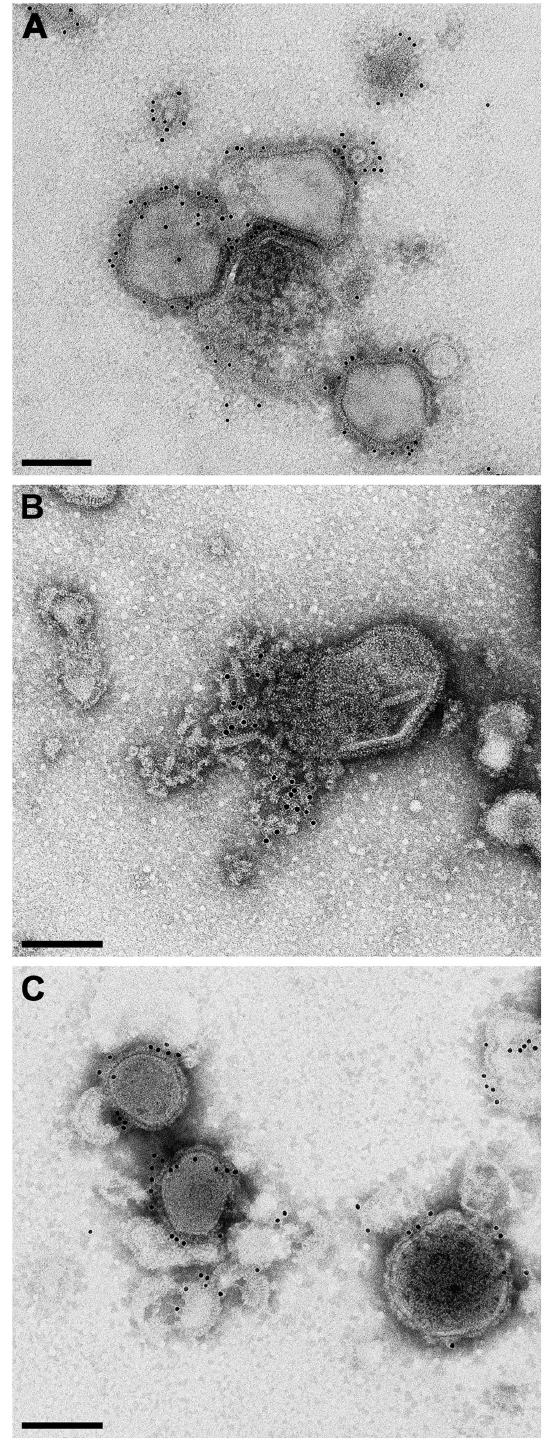
Figure 3. Immunoelectron microscopy of purified virions. Immunolabeling of chNDVFHN H5 was performed PMV8 using a serum against APMV-8 F (A), a monoclonal antibody against NDV NP (B), or a serum against AIV H5 (C), followed by gold-tagged secondary antibodies. Scale bars: 150 nm. doi: